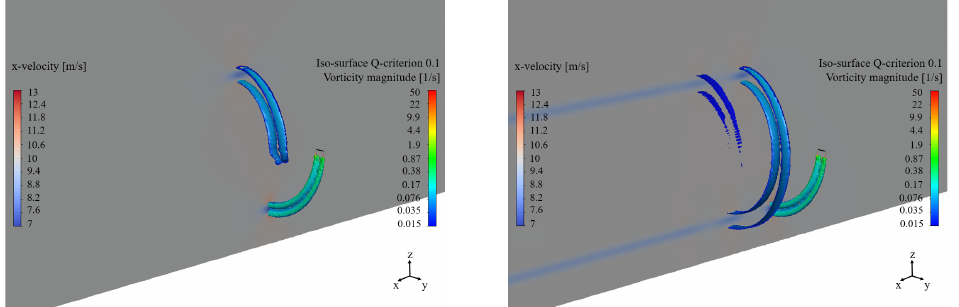
Figure 13. Visualization of the wake after ( left ) the first loop and ( right ) the last loop for the crosswind flight with uniform inflow. Note that the flow is from right to left. The contour plot shows the component of the wind velocity in the x-direction. The gray color indicates no disturbance; blue indicates velocity deficit; and red indicates velocity acceleration.